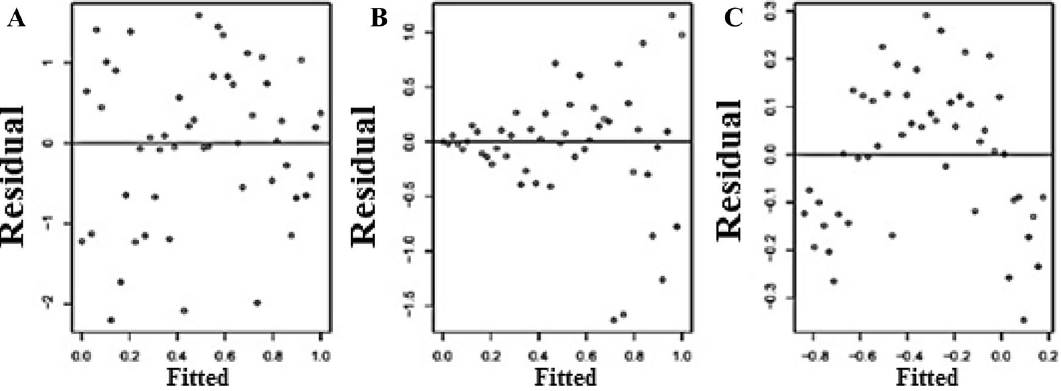
Fig. 3 Interpretation of residual values in a regression and possible states. a Ideal mode, b nonuniformity mode, c nonlinear mode (Chatterjee et al.